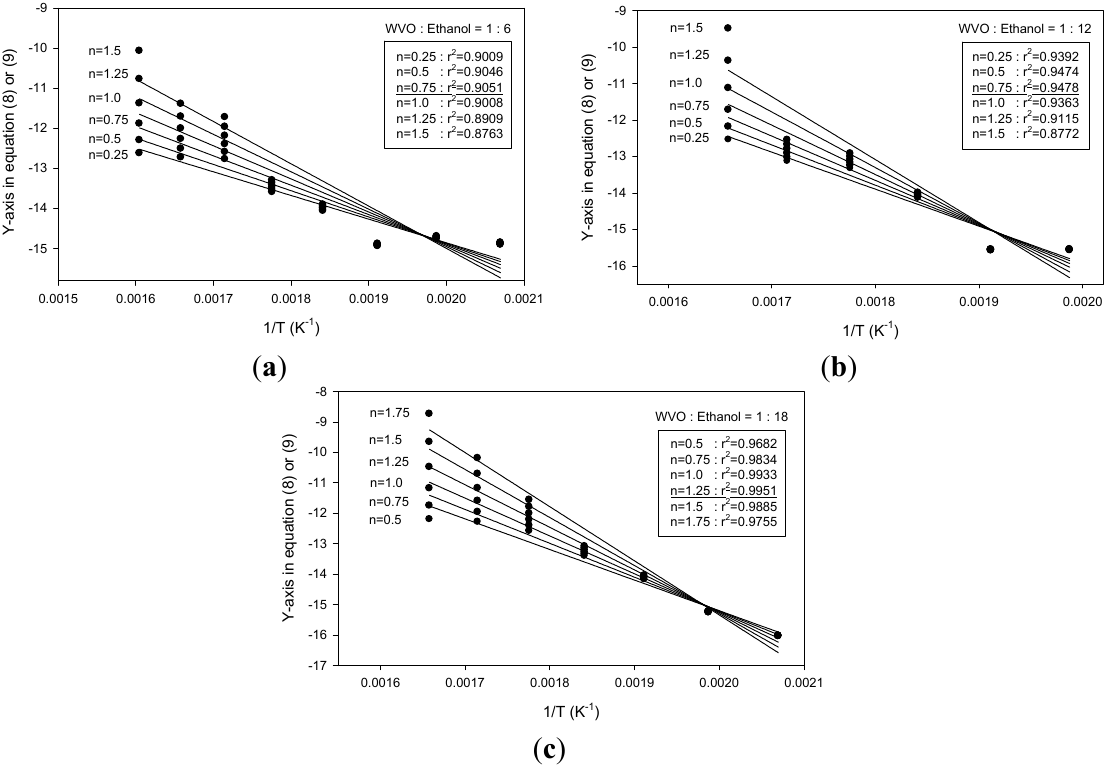
Figure 4. Application of the kinetic analysis method for SCE with WVO and ethanol at molar ratios of: ( a ) 1:6; ( b ) 1:12; and ( c ) 1:18.